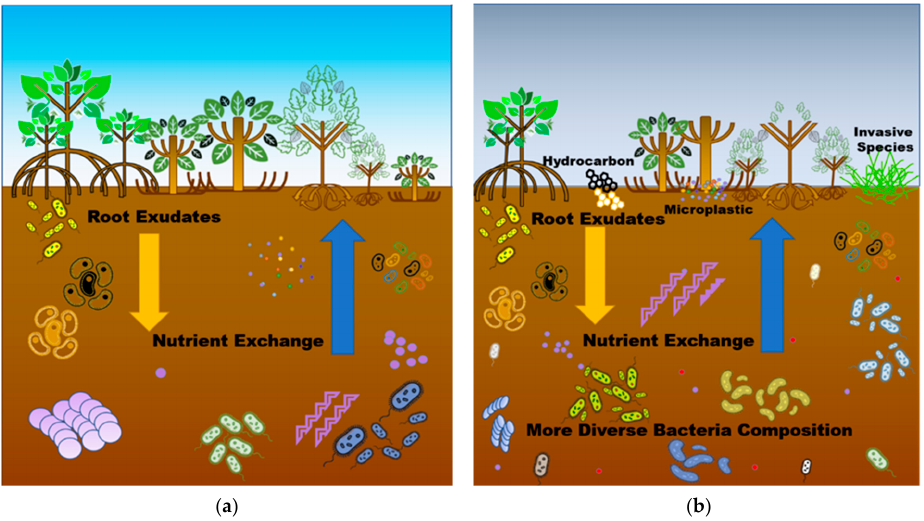
Figure 5. The key function of mangrove sediment microbes using nutrient exudates from tree roots and the surrounding environment. ( a ) Well-preserved mangrove sediment has lower microbial diversity compared to ( b ) disturbed mangrove sediment which has a more diverse structural composition adapting and utilizing different nutrient sources in the environment. Mangrove restoration work has been performed in small patches around the world and has been mainly concentrated in Asia [138]. While mangrove restoration often em- phasizes forest coverage and seedling numbers while leaving out biodiversity and stand structures as the main focal point, and monospecies replantation approaches have been used to ease plantation and produce a uniform harvest for timber [139], multiple studies have been completed to elevate mangrove restoration success and environmental impact ratios [140,141]. Many studies have pointed out that through mangrove restoration of na- tive species, the microbial structure composition could increase the microbial structure of native, mature, mangrove forests [58,75]. The selection of mangrove restoration species have an effect on both the nutrients and microbial diversity caused by the enrichment of organic matter and induced biogeochemical cycles [77]. Restored mangroves have been found to have accelerated rates of carbon acquisition and ultimately higher sequestration rates compare to matured mangroves, while at the same time having a higher emission of methane [78], thus providing a clue to increase mangrove restoration as an alternative so- lution to increase carbon sequestration rates in coastal regions. Restored mangrove forests have a similar prokaryote composition compared to well- preserved mangrove areas but have different diazotroph structures when the restored mangrove was planted in a previously invasive species vegetation, the differences in veg- etation type shape the nutrient availability and prokaryotes succession [75]. Feedback ad- justments of microorganisms are highly sensitive to the surrounding nutrients and the restoration of mangroves. Gammaproteobacteria and Deltaproteobacteria have a higher proportion in dis- turbed environments compared to those found in well-protected mangrove sediments [102] and replace Anaerolineae in microcosm hydrocarbon incubation conducted by Taket- ani (2010) [111]. Sulfur-dependent prokaryotes of Gammaproteobacteria and Deltaprote- obacteria are abundant in both before and after pollutants such as hydrocarbon but orders such as Alteromonadales were reported to have increased in amount as a response to oil contamination [72]. A significant upsurge in the diversity of bacteria has been detected in